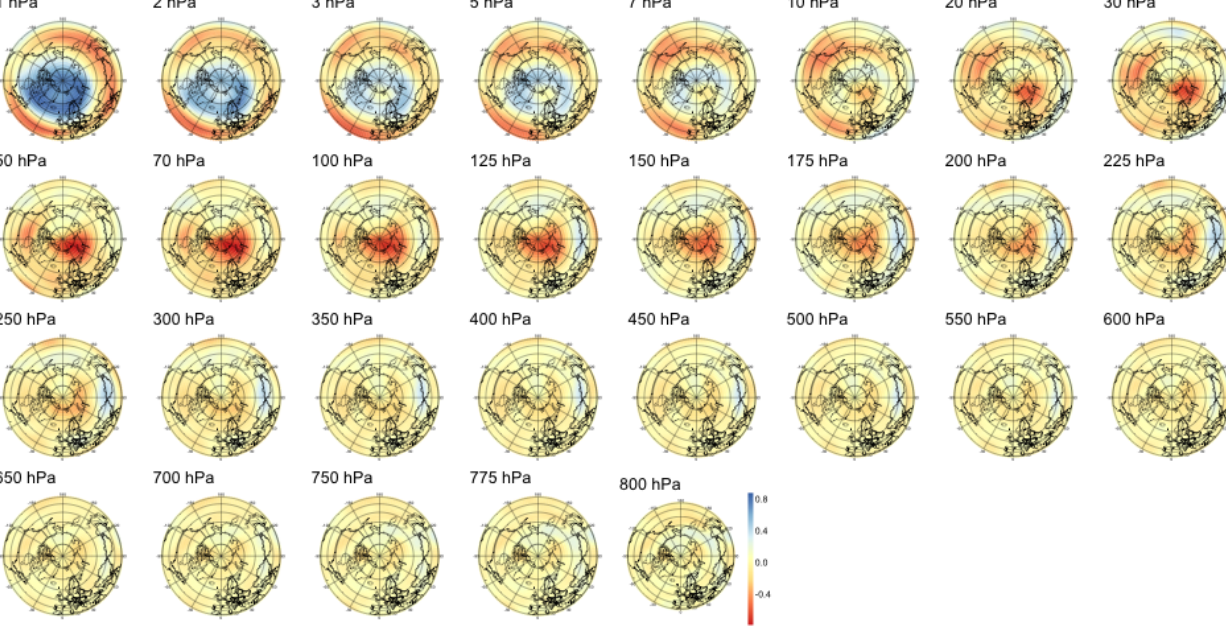
Figure B4. Pattern of PV anomalies maximizing correlation with the SSW index at a lead time of 44d.